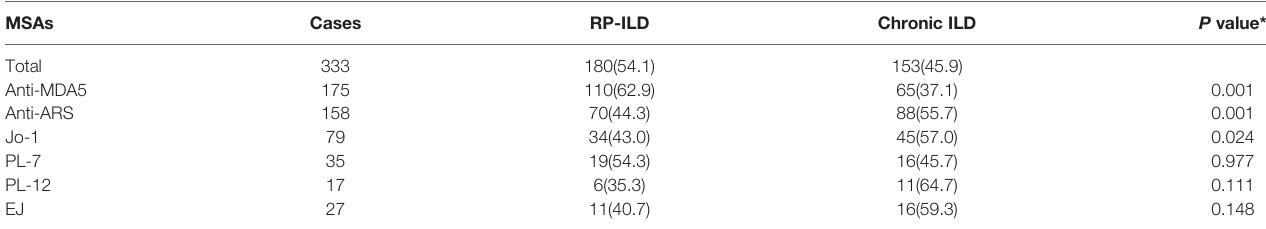
TABLE 2 | Frequencies of RP-ILD among patients with different MSAs.